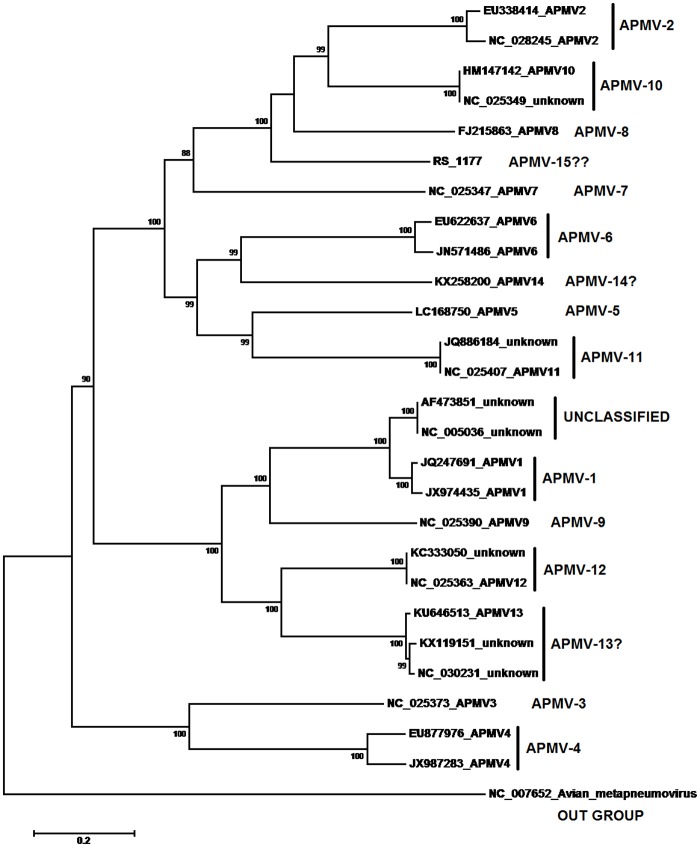
Phylogenetic tree of representative members of Avulavirus.Phylogenetic analysis using the Neighbor-joining method with 1,000 bootstrap replicates based on complete genome sequences of APMV-1 to APMV-14 and other unclassified Avulavirus. Evolutionary distances were computed using the Kimura 2-parameter substitution model. The scale bar is shown on the bottom left. The numbers at the nodes represent bootstrap values higher than 70. Sequences used were available in public databases and the accession numbers along with their branch data are shown. Label:?- Species not recognized by ICTV;??- New isolate RS-1177.